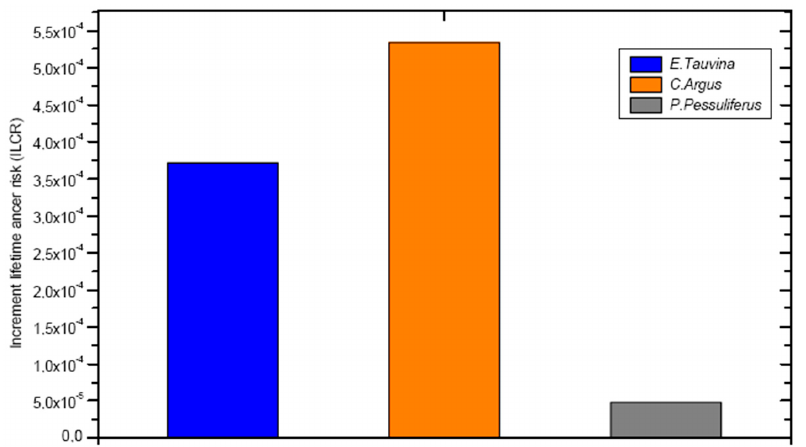
Figure 4. Incremental lifetime cancer risk and cancer risk (ILCR) of the ∑ PAHs concentrations for three endemic fish in